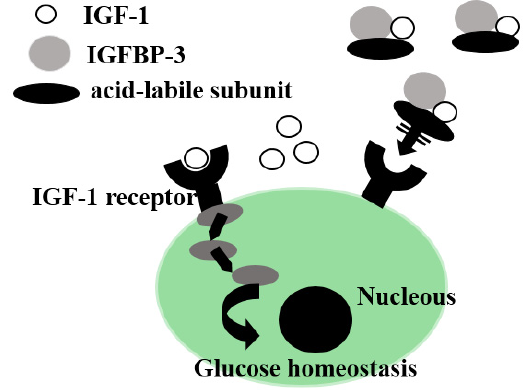
Figure 1. Putative mechanisms by which a decrease in free IGF ‐ 1 levels cause insulin resistance in patients with HCV-related CLD. IGF-1, insulin-like growth factor; IGFBP, IGF-binding protein; HCV, patients with HCV ‐ related CLD. IGF ‐ 1, insulin ‐ like growth factor; IGFBP, IGF ‐ binding protein; HCV, Hepatitis C virus; CLD, chronic liver Hepatitis C virus; CLD, chronic liver disease.